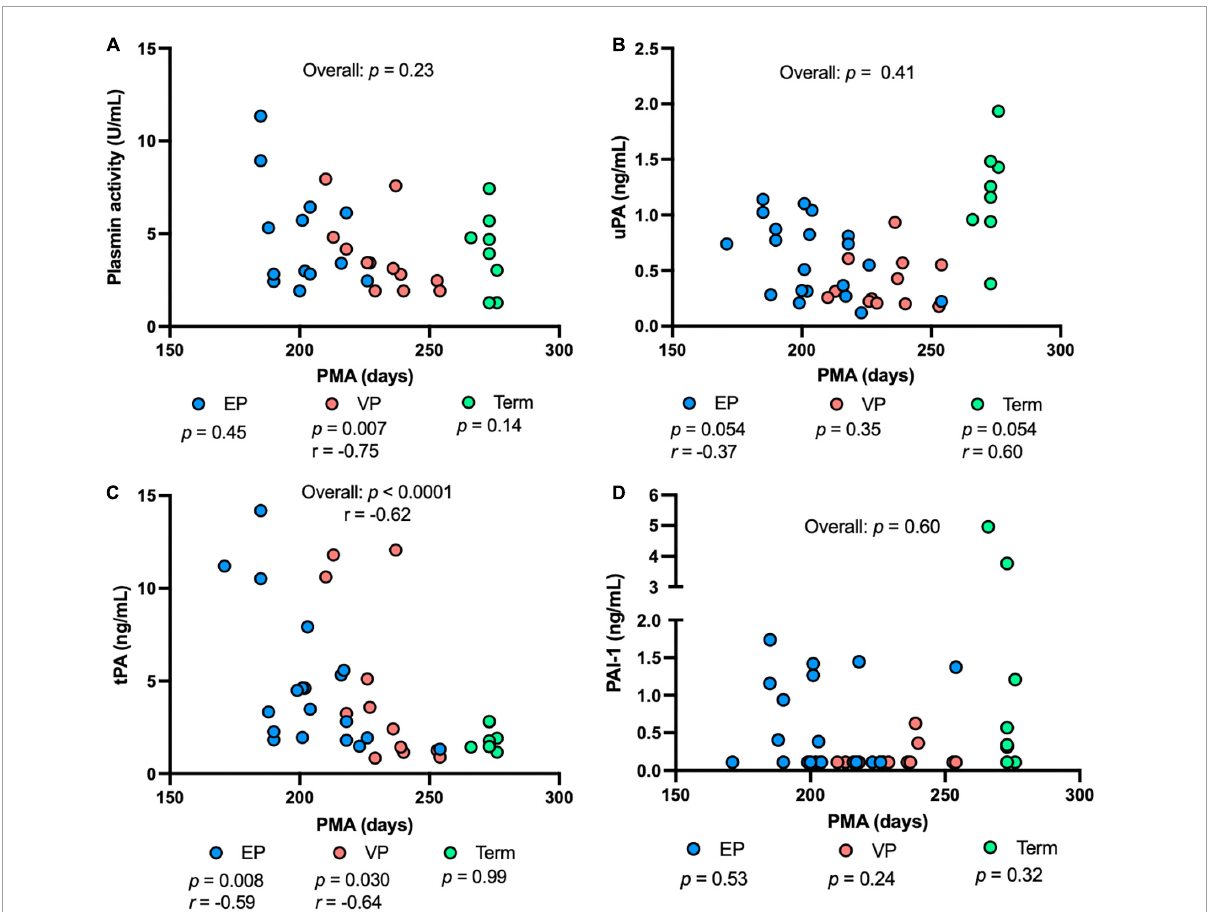
FIGURE4 The levels of plasmin system components in milk from extremely preterm-(EP), very preterm-(VP), and term-delivering mothers across postmenstrual age (PMA). (A) Plasmin activity across PMA; (B) human urokinase-type plasminogen activator (uPA) across PMA; (C)